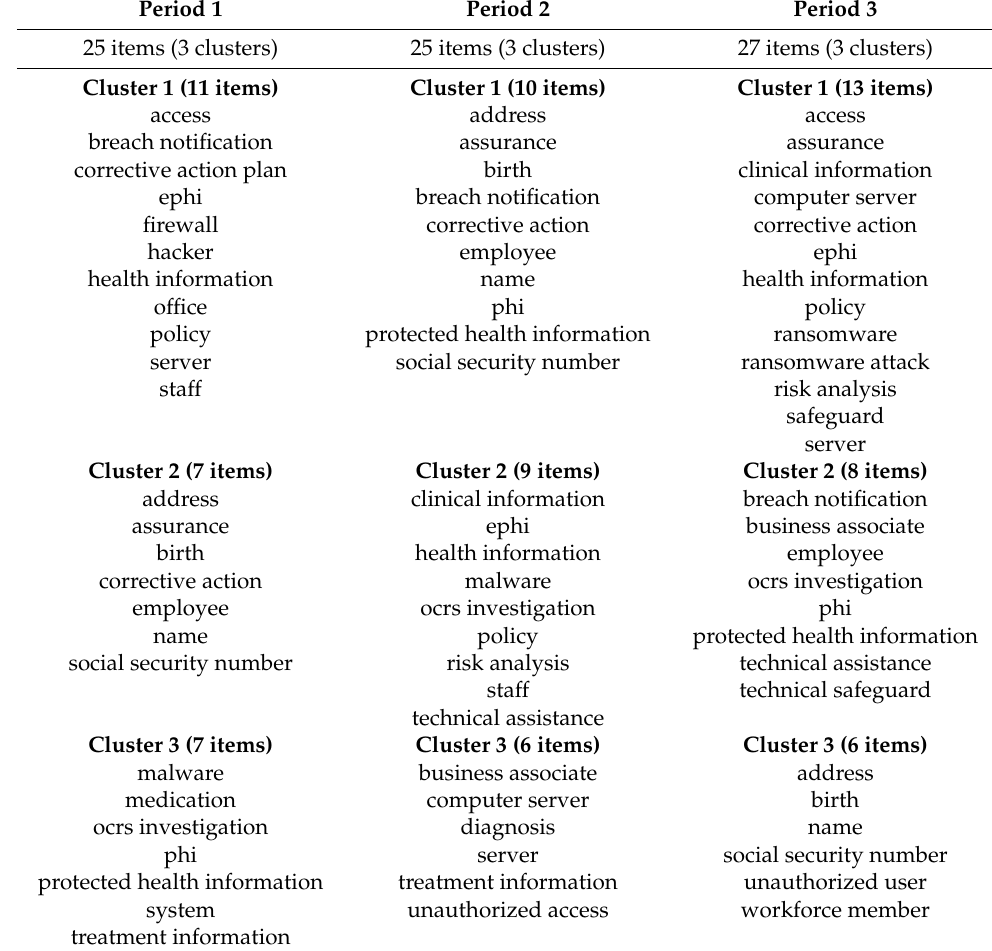
Table 1. Clusters of Co-occurring Keywords in Hacking/IT Incident in Three